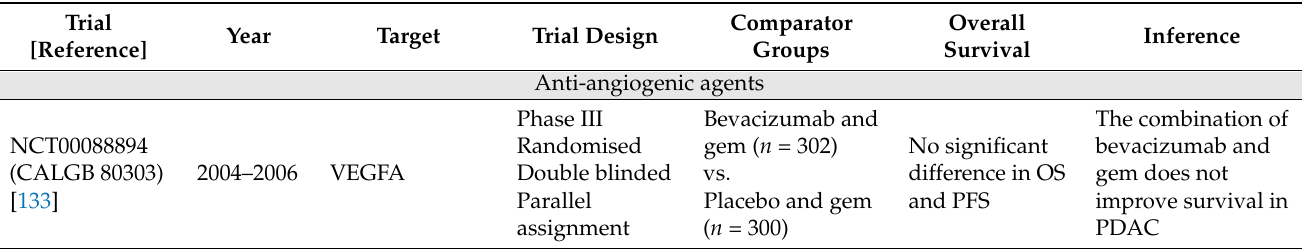
Table 2. Failed clinical trials targeting the PDAC tumour